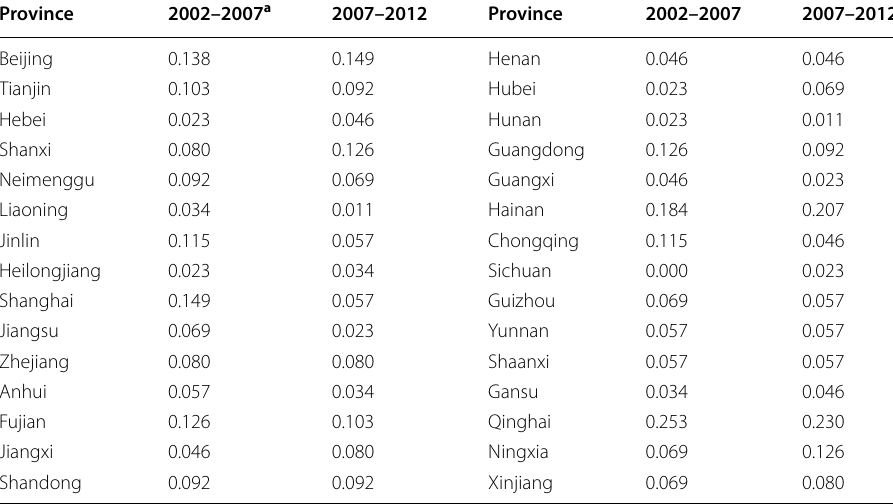
Table 13 IO data quality in each